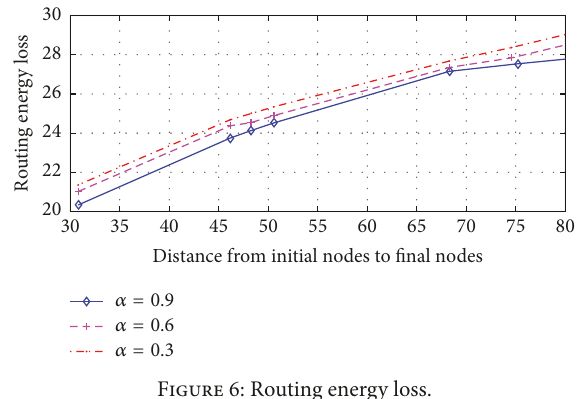
Figure 6: Routing energy loss.